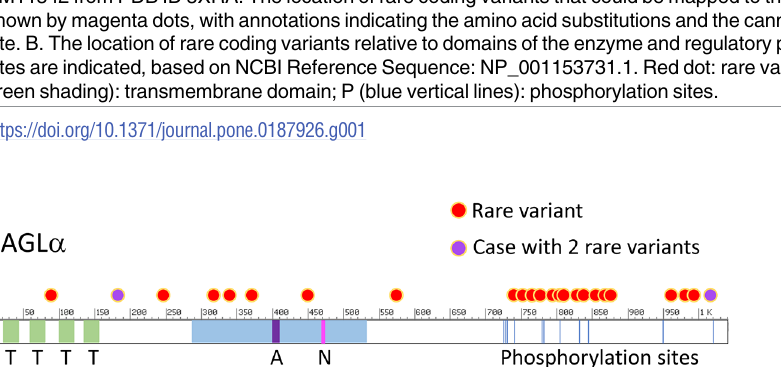
PLOS ONE | https://doi.org/10.1371/journal.pone.0187926 November16,